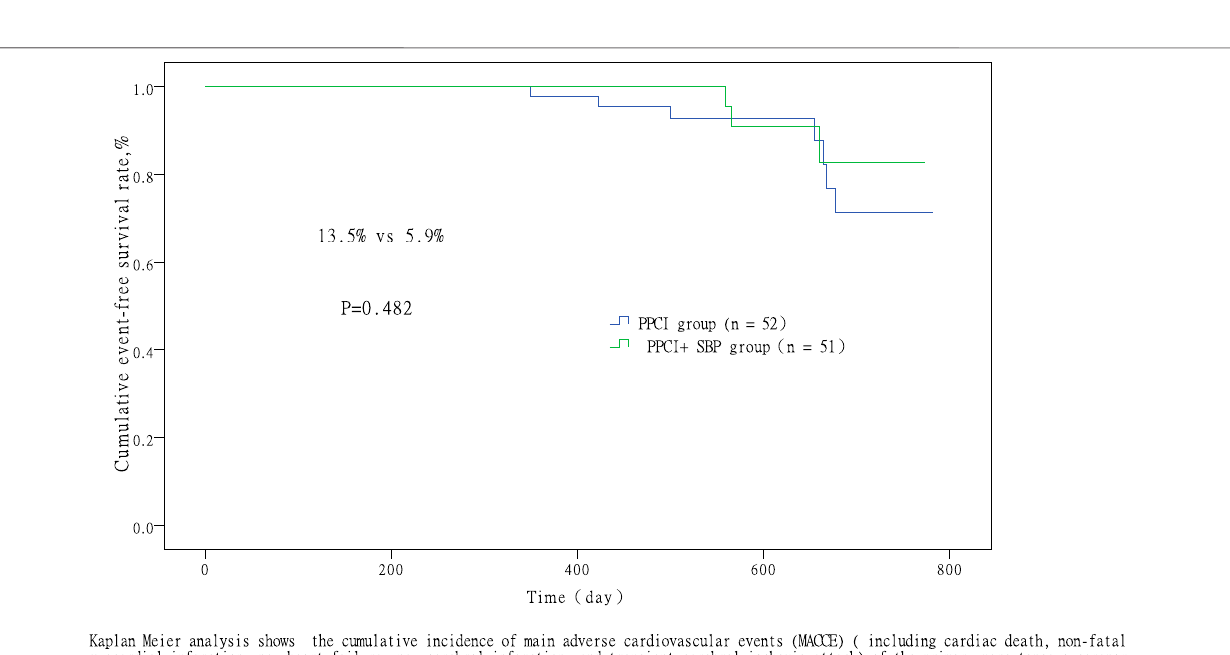
Frontiers in Pharmacology |